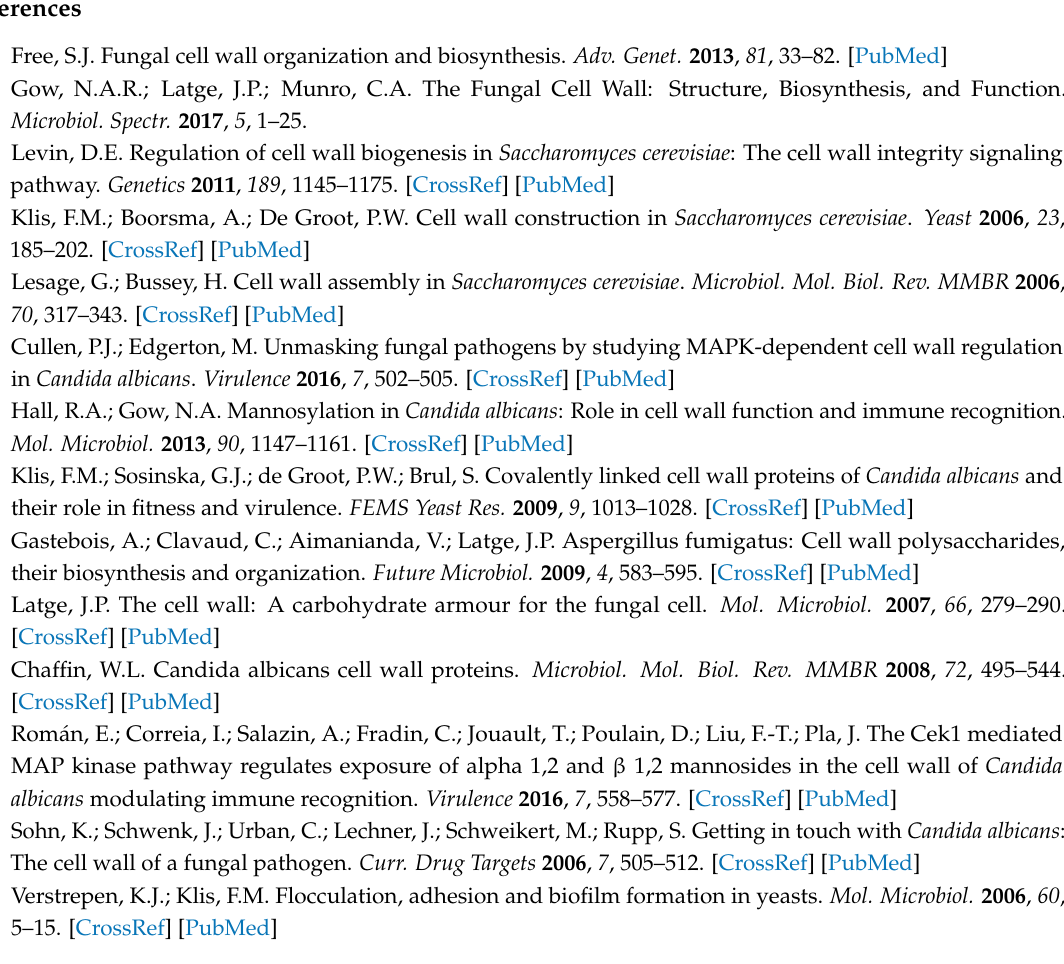
Table S1: Cell wall enriched proteins from wild-type cells identified by MASS SPEC analysis; Table S2: Cell wall enriched proteins from ste12 ∆ cells identified by MASS SPEC analysis; Table S3: Cell wall enriched proteins from dig1 ∆ cells identified by MASS SPEC analysis; Table S4: Control for MASS SPEC